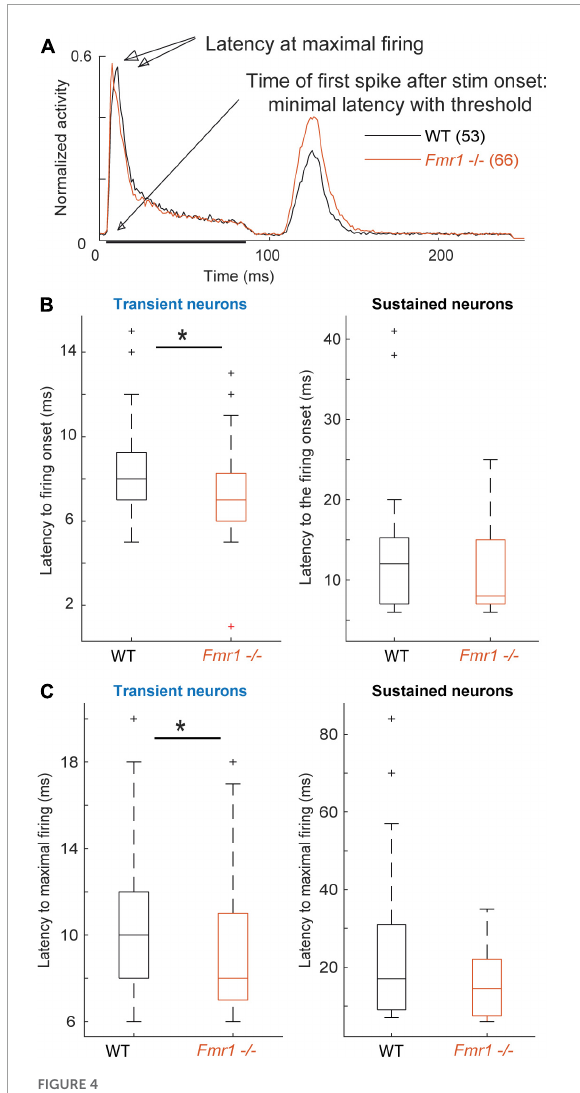
FIGURE4 Fmr1 -/- neurons exhibit an earlier and stronger activation. (A) Averaged and normalized PSTH of all cells over all conditions during the FRA for all transient WT and Fmr1 -/- neurons. (B) Boxplot representation of the averaged latency in transient (53 WT, 66 Fmr1 -/- ) and sustained neurons (34 WT, 16 Fmr1 -/- ). (C) Boxplot representation of the timing of maximal spiking in transient and sustained neurons from WT and Fmr1 -/-